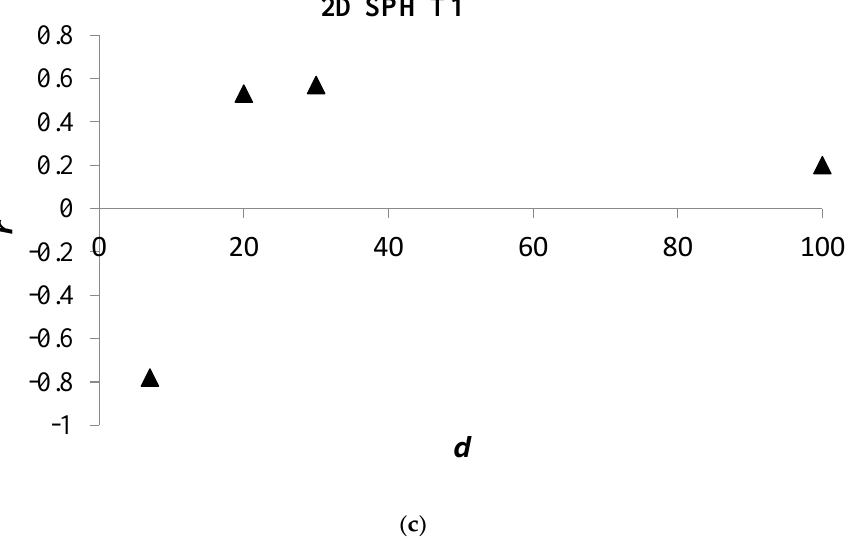
Figure 24. Plot of r versus d for: ( a ) (p–u) ; ( b ) (p–v) ; and ( c ) (u–v) pairs of data (configuration: T1).